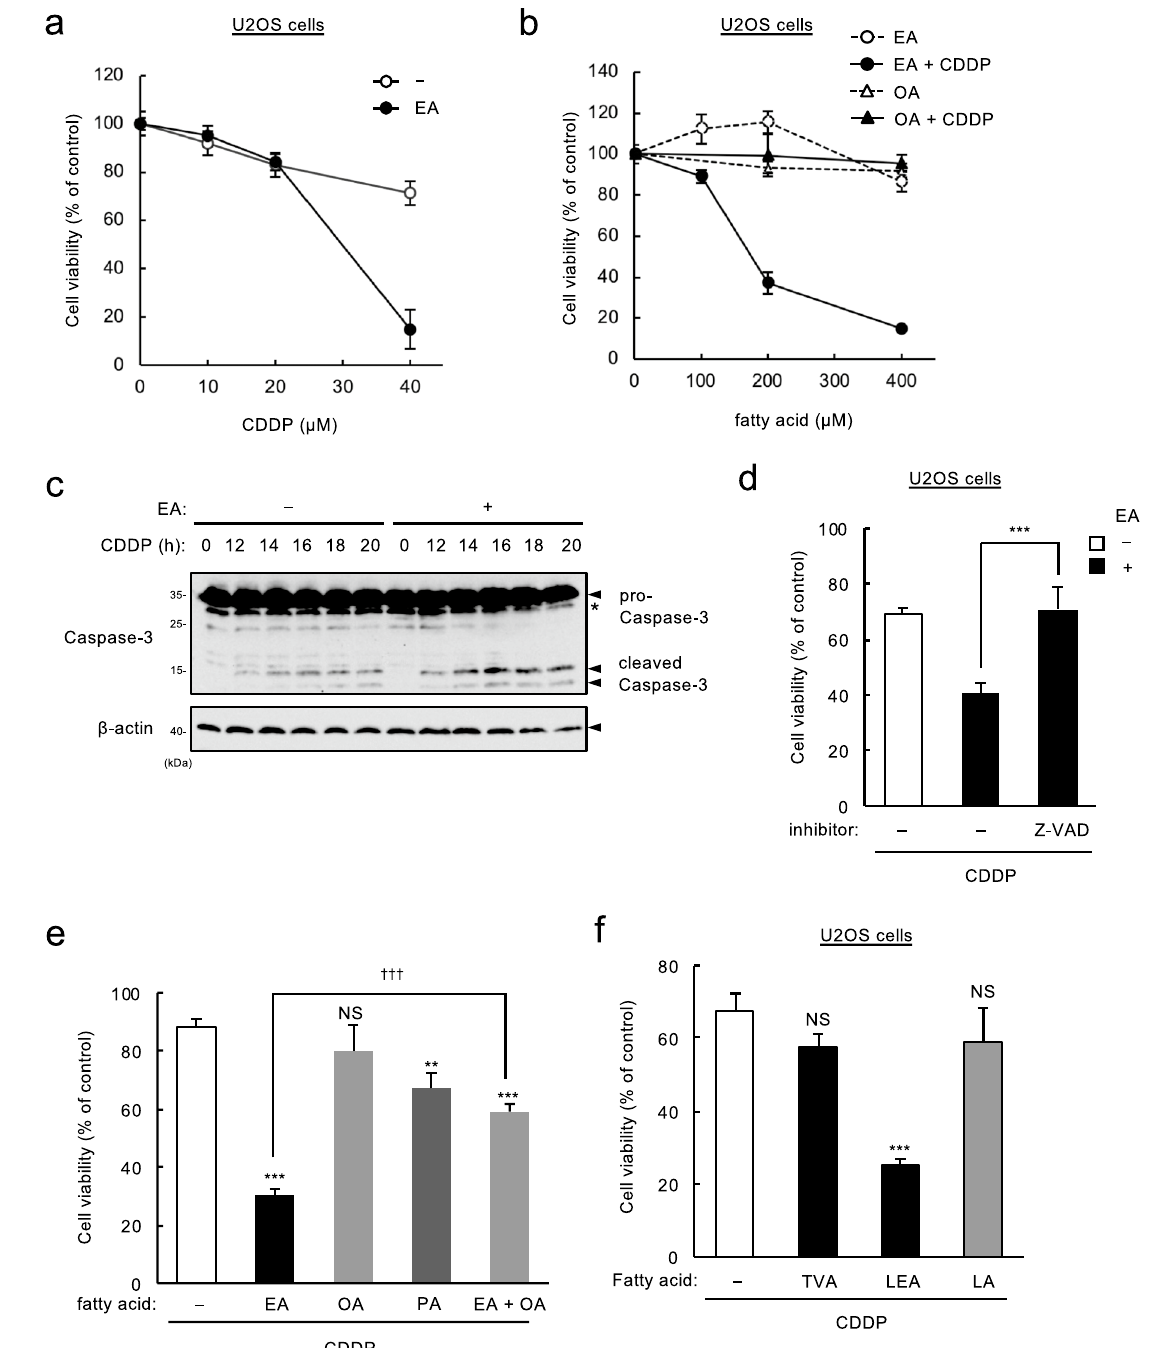
Figure 1. Major industrial TFAs promote CDDP-induced apoptosis. ( a ) U2OS cells were pretreated with or without 200 μM EA for 12 h, and then stimulated with various concentrations of CDDP for 24 h, subjected to cell viability assay. Data shown are the mean ± SD (n = 3). ( b ) U2OS cells were pretreated with the indicated concentrations of OA or EA for 12 h, and then stimulated with or without 40 μM CDDP for 24 h, subjected to cell viability assay. Data shown are the mean ± SD (n = 3). ( c ) U2OS cells were pretreated with or without 200 µM EA for 12 h, and then stimulated with 40 μM CDDP for the indicated time periods. Cell lysates were subjected to immunoblotting with the indicated antibodies. *, non-specific band. ( d ) U2OS cells were pretreated with or without 200 µM EA for 11.5 h, treated with the pan-caspase inhibitor z-VAD-fmk for 0.5 h, and followed by stimulation with 40 μM CDDP for 24 h, subjected to cell viability assay. Data shown are the mean ± SD (n = 3). ( e and f ) U2OS cells were pretreated with the indicated fatty acids at 200 μM for 12 h, and then stimulated with 40 μM CDDP for 24 h, subjected to cell viability assay. Data shown are the mean ± SD. NS, not significant; ** p < 0.01; *** p < 0.001 (vs. cells without any fatty acid); ††† p <